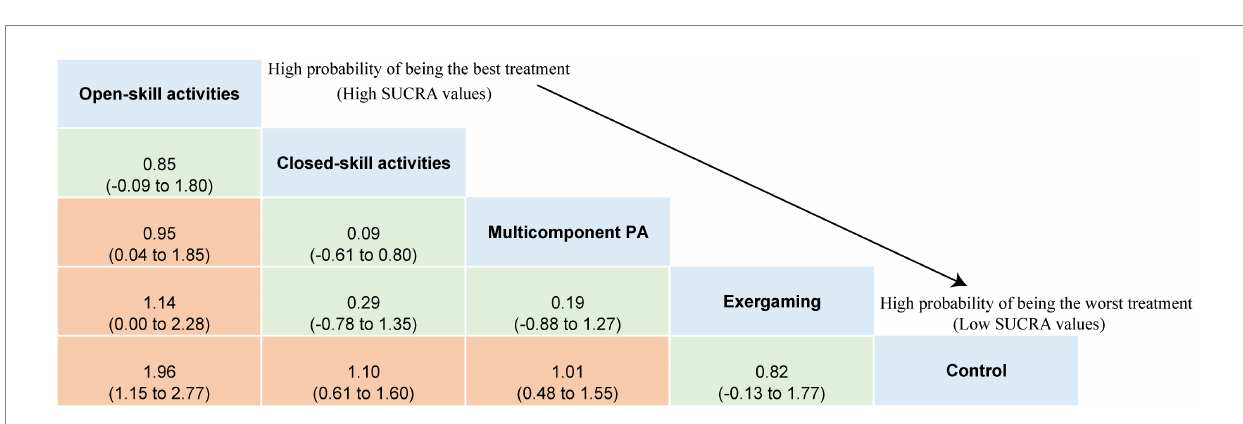
FIGURE 3 League table of outcome analyses for executive functions. PA, physical activity; SUCRA, the surface under the cumulative ranking